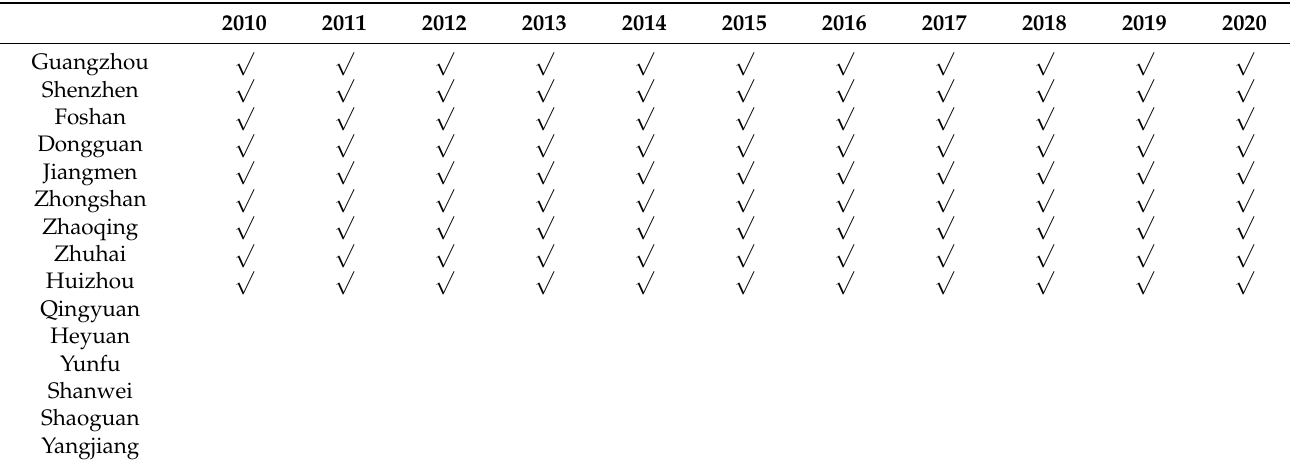
Table 4. Core-marginal analysis of the housing prices’ association network in the PRDUA from 2010 to 2020.